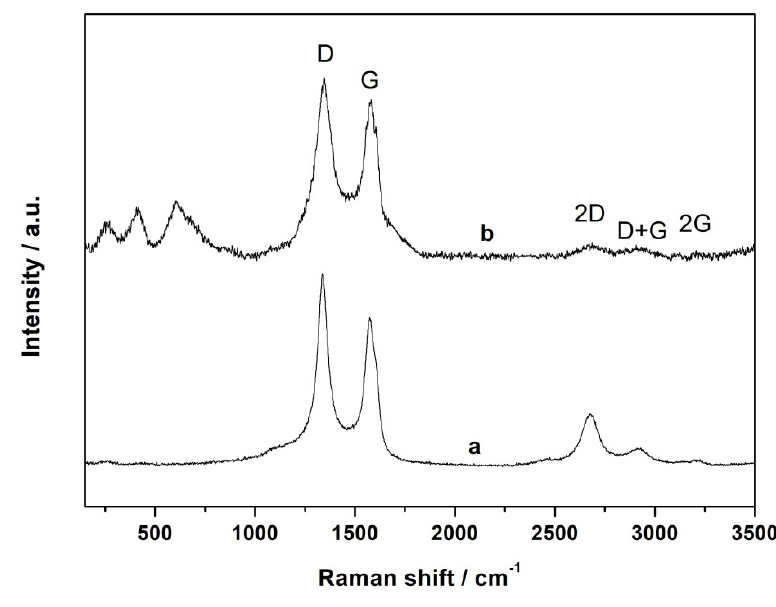
Figure 4. The Raman spectra of rGO-COOH (a) and CFeN@rGO-COOH (b). bauer spectroscopy at room temperature. The analysis of the Mössbauer spectrum for thermally treated, Prussian-blue-supported rGO was performed by fitting two doublets D1 and D2 and one singlet (Figure 5). Furthermore, the identification of appropriate iron species was performed based on correlating the obtained Mössbauer spectra to the literature data. The existence of a singlet with a slight isomer shift (IS = − 0.03 mm s − 1 ) near zero and the lack of a quadrupole splitting (QS) represented the Fe 2+ cation with a low-spin state [46]. This can be interpreted as super-paramagnetic iron or iron carbides preserved by the carbon matrix. The latter was confirmed in the XRD pattern and TEM images. Furthermore, the doublet D1 with an IS of 0.60 mm s − 1 and QS of 0.36 mm s − 1 was assigned to Fe 3+ (HS), indicating a change in the environment of the high-spin state of iron [53]. The second doublet D2 (IS = 1.1 mm s − 1 , QS = 1.0 mm s − 1 ) represented high-spin state Fe 2+ [54]. Both doublets D1 and D2 were correlated with iron atoms that were octahedrally coordinated with carbon and nitrogen atoms, respectively.